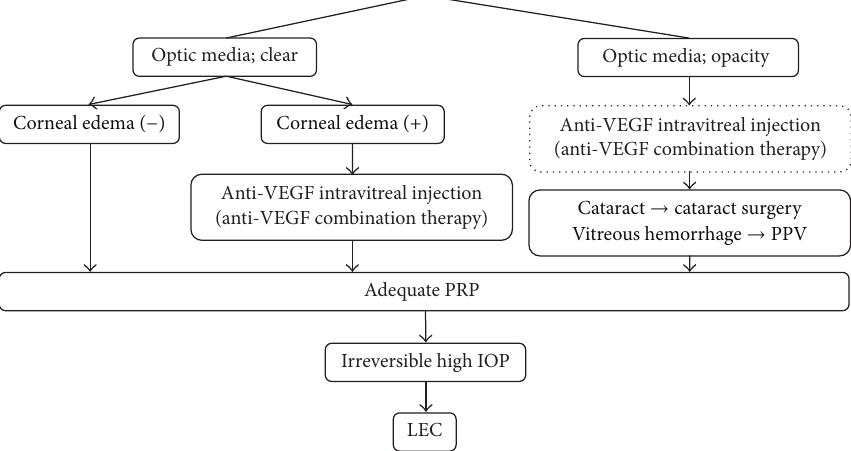
Figure 1: Treatment plan of NVG in Oita University Hospital. A variety of treatments were administered in the present study depending on NVG patient status, including panretinal laser photocoagulation (PRP), anti-VEGF intravitreal injection (stand-alone or in combination with other treatments), cataract surgery, pars plana vitrectomy (PPV), and trabeculectomy with 0.02% mitomycin C (LEC). PRP, panretinal laser photocoagulation; PPV, pars plana vitrectomy, LEC, trabeculectomy with mitomycin C; VEGF, vascular endothelial growth